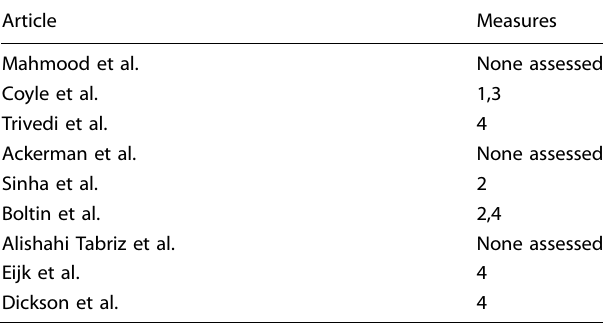
Table 2. The types of triage ef fi ciency measure each article assessed.